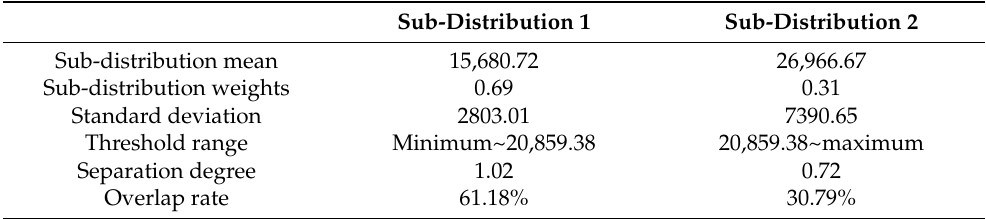
Table 4. Parameter values of each sub-distribution of the improved mixed monolithic sieving model for image B.